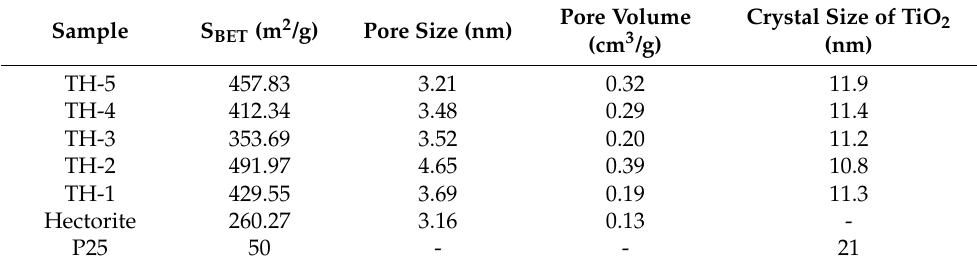
Table 1. Specific surface area (S BET ), pore size, pore volume, and crystal size of